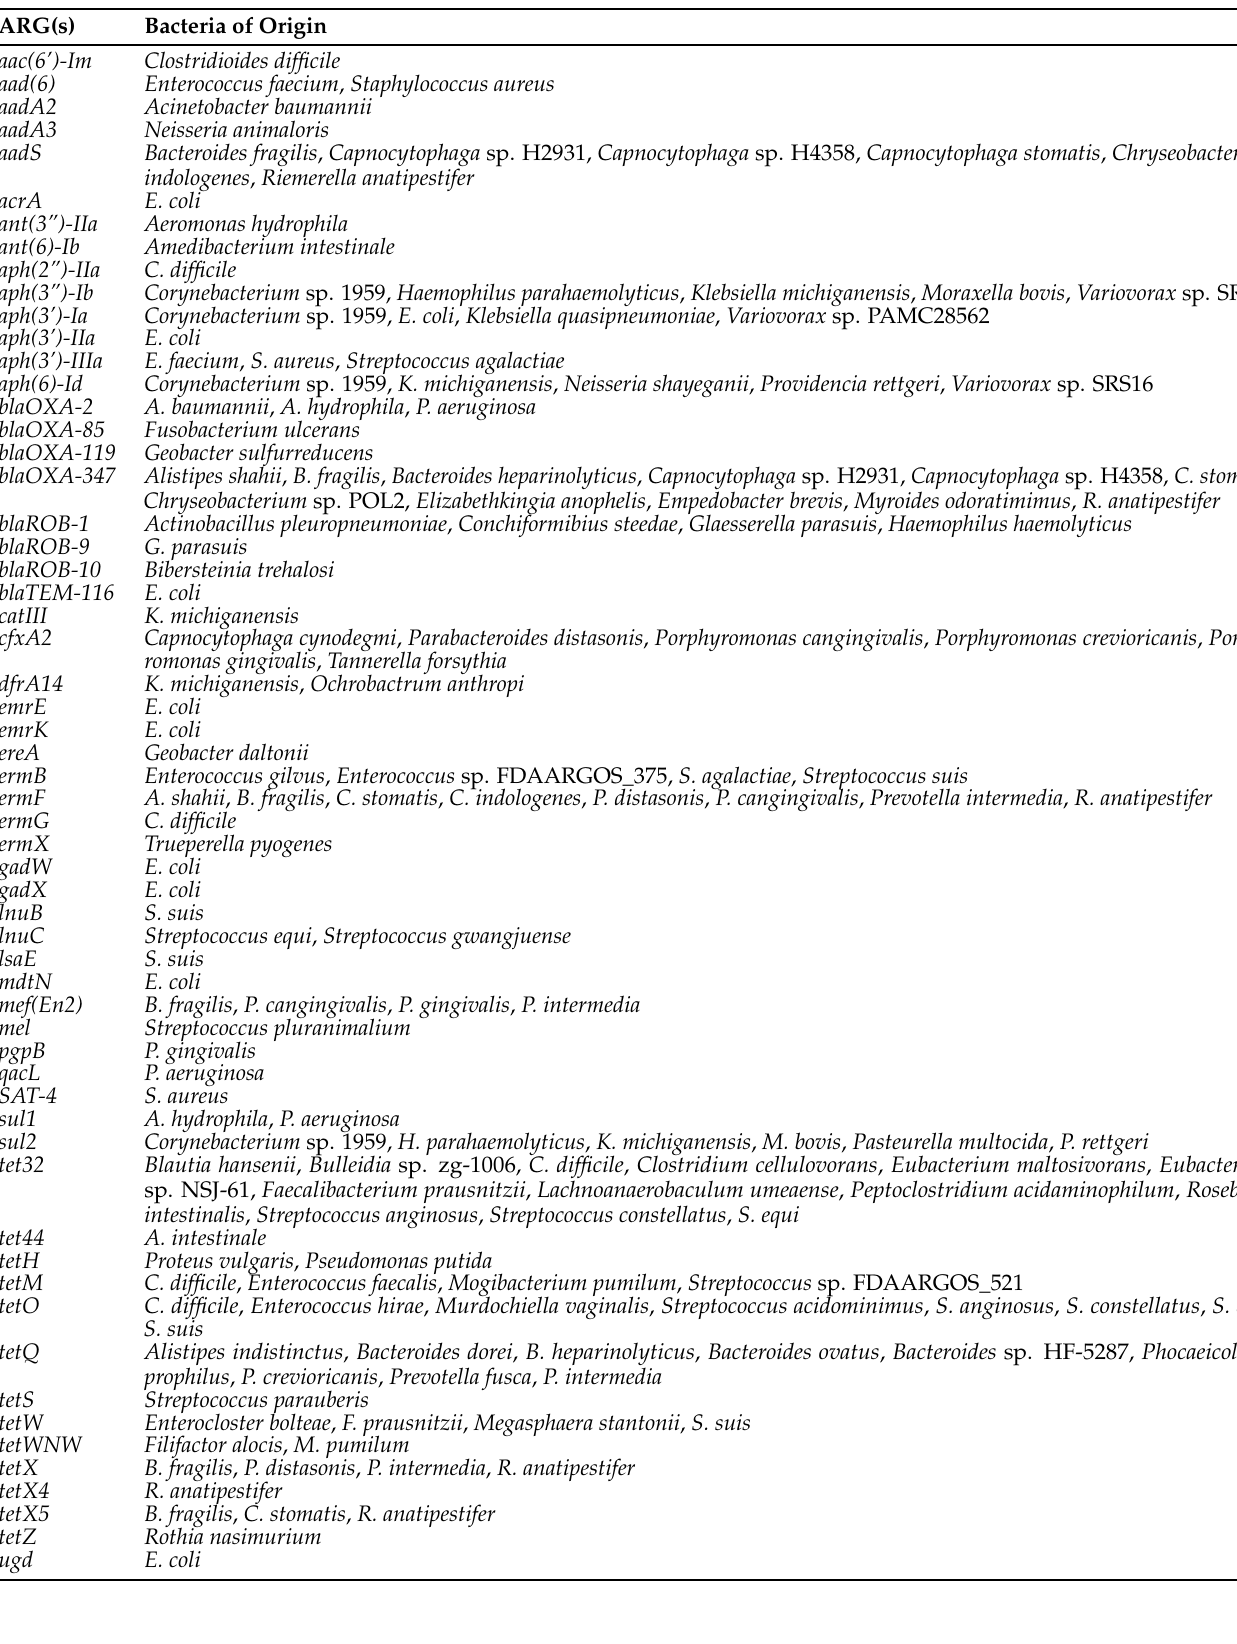
Table 3. Identified ARGs and the predicted bacterial species of origin. For ten genes ( aadA5 , aadA15 , ant(2”)-Ia , bacA , blaACT-12 , cmlA9 , fosA2 , oqxA , tetX1 and tetY ), no species-level prediction was obtained as to which bacterium the contig carrying the gene might have originated